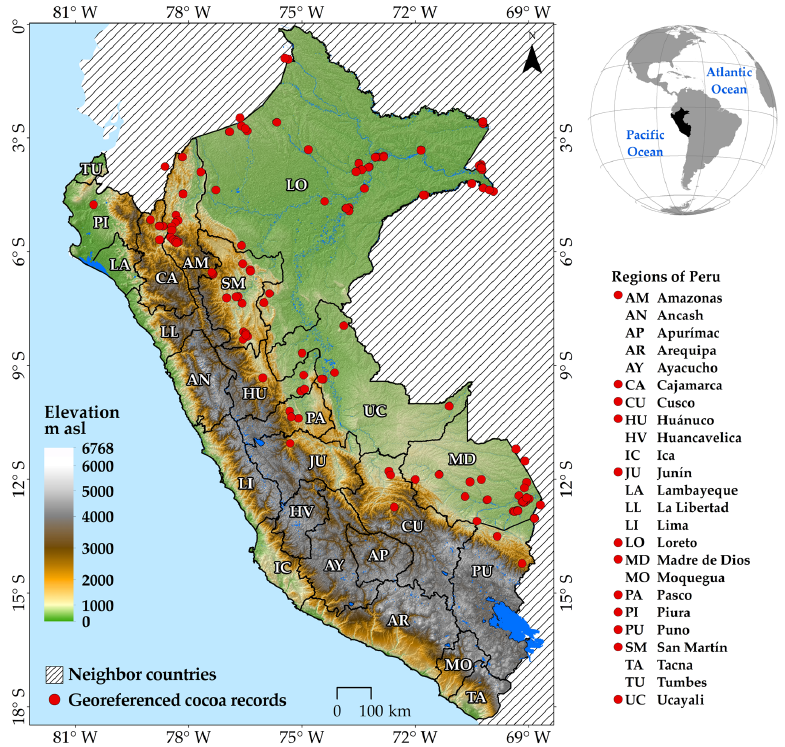
Figure 1. Location and elevational gradient of Peru, including cocoa occurrence.